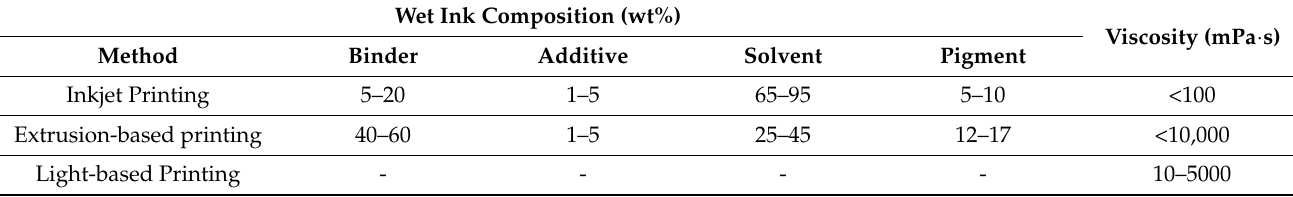
Table 1. Typical compositions and viscosity properties of inks for general printing technologies. Values adapted with permission from ref. [67]. Copyright 2020 American Chemical Society and ref. [68]. Copyright 2020 RSC and under Creative Commons